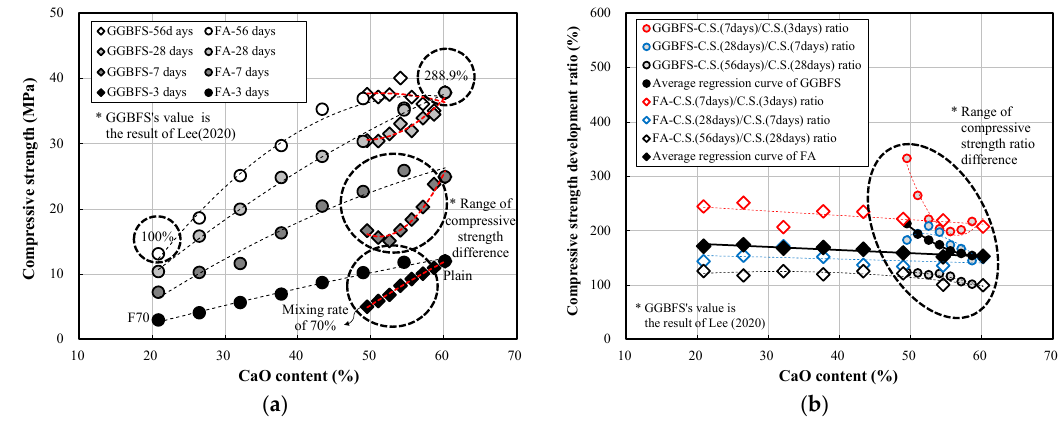
Figure 17. Results of the ( a ) compressive strength and ( b ) compressive strength development rate according to the varied CaO content.